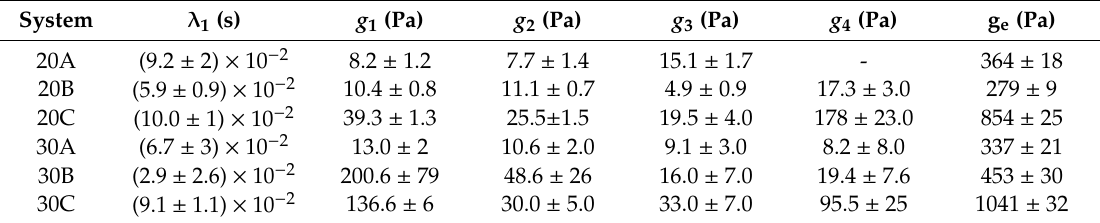
Table 1. Generalized Maxwell model (Equations (1) − (2)) fitting parameters referring to the data ( G (cid:48) and G ”) shown in Figure 1a,b. While λ 1 indicates the first Maxwell element relaxation time, g i represents the spring constant value of the ith Maxwell element. Finally, g e represents the purely elastic element. System